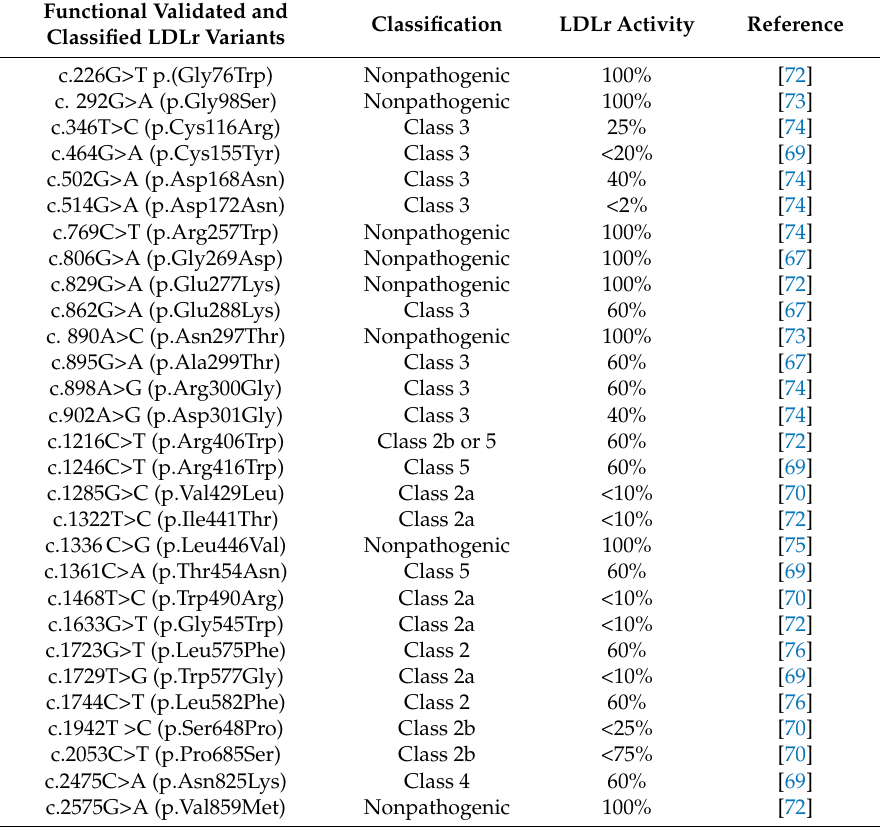
Table 2. LDLr variants characterized and classified by fluorescent-based methodologies at